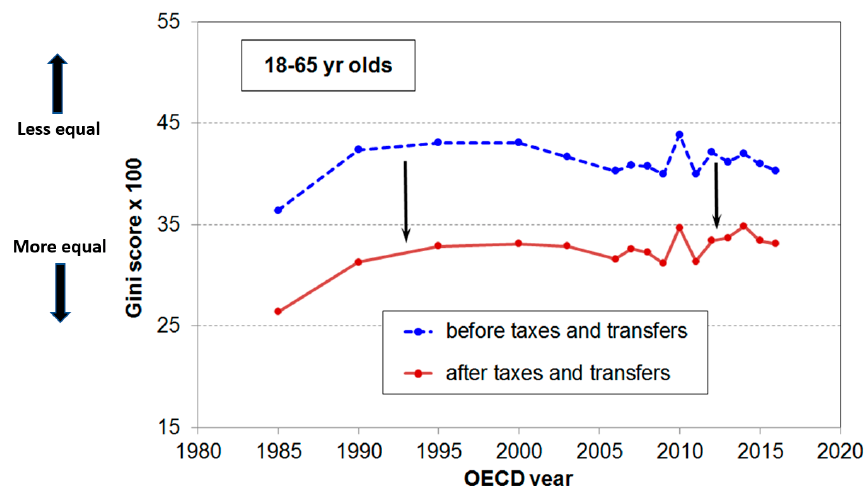
Figure 1. Gini score (x100) for total income before and after taxes and transfers in New Zealand. Between 1960–1990, there was little change in inequality followed by a steep rise which was associated with income tax and benefit changes. Reproduced with permission from [19]. Copyright Ministry of Social Development, New Zealand, 2019.